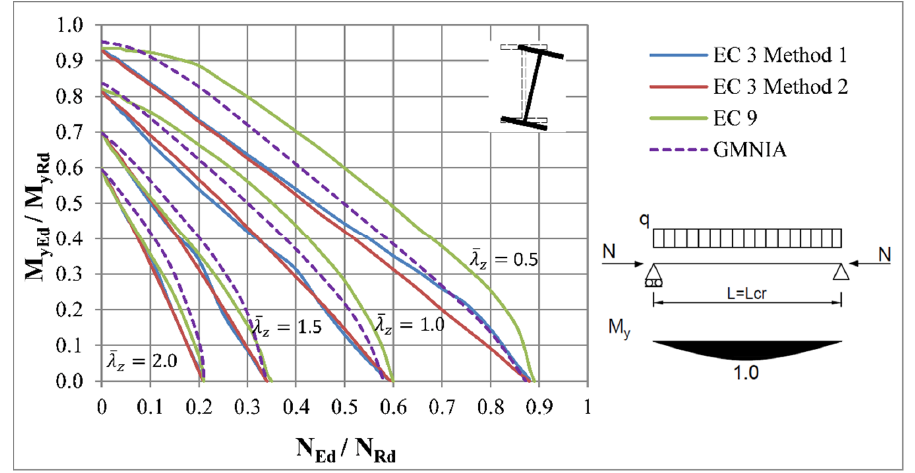
Figure 23. Interaction curves for laterally unrestrained beam-columns with IPE 100 cross-section with free warping.